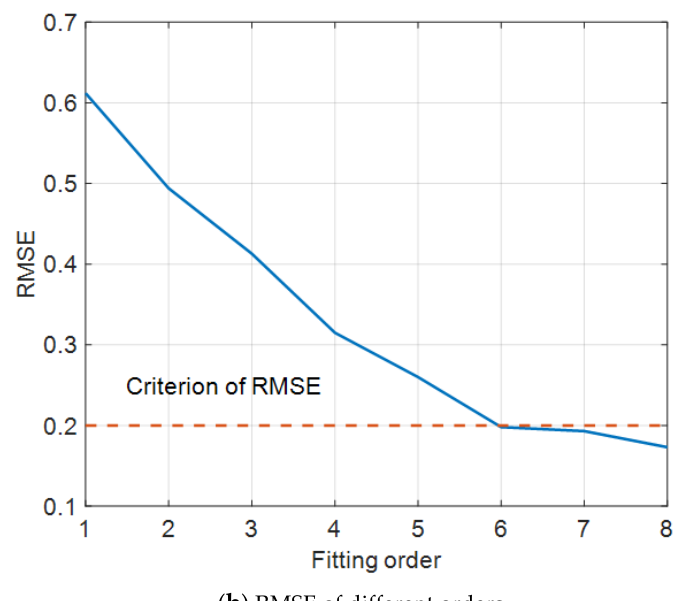
Figure 7. The Fourier curve fitting results (20 April 2017).